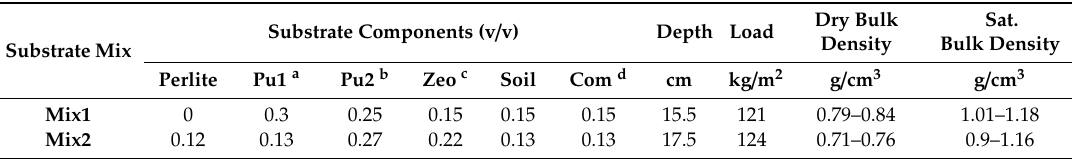
Table 1. Substrate component fractions by volume (v / v) for Mix1 and Mix2, depth of substrate, load, dry and saturated (Sat.) bulk density.